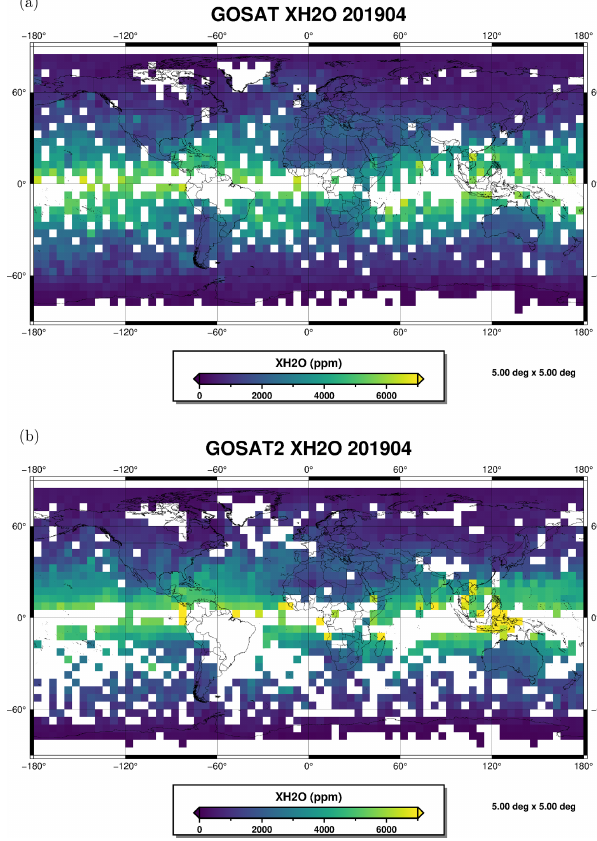
Figure 6. Maps of gridded XH 2 O data for April 2019: (a) GOSAT; (b)